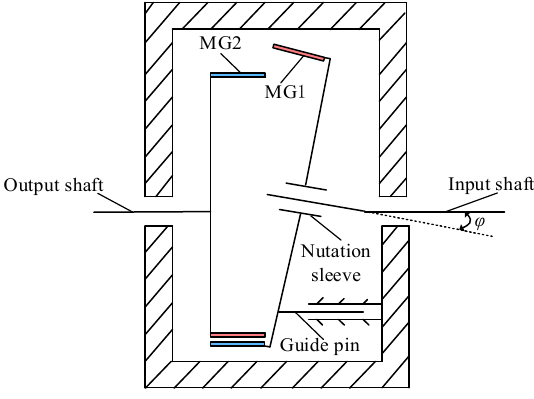
Figure 1. Sketch of the inner-type nutation magnetic drive.